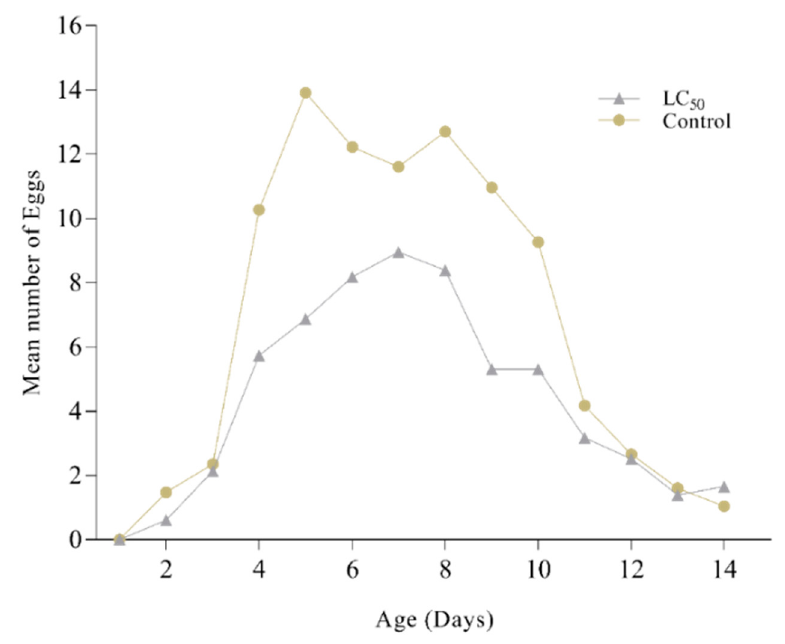
Figure 6. Mean number of eggs from Plutella xylostella after treatment with Metarhizium anisopliae. Grey dots show the mean numbers of eggs laid by P. xylostella after treatment by M. anisopliae while yellow dots show the control group.